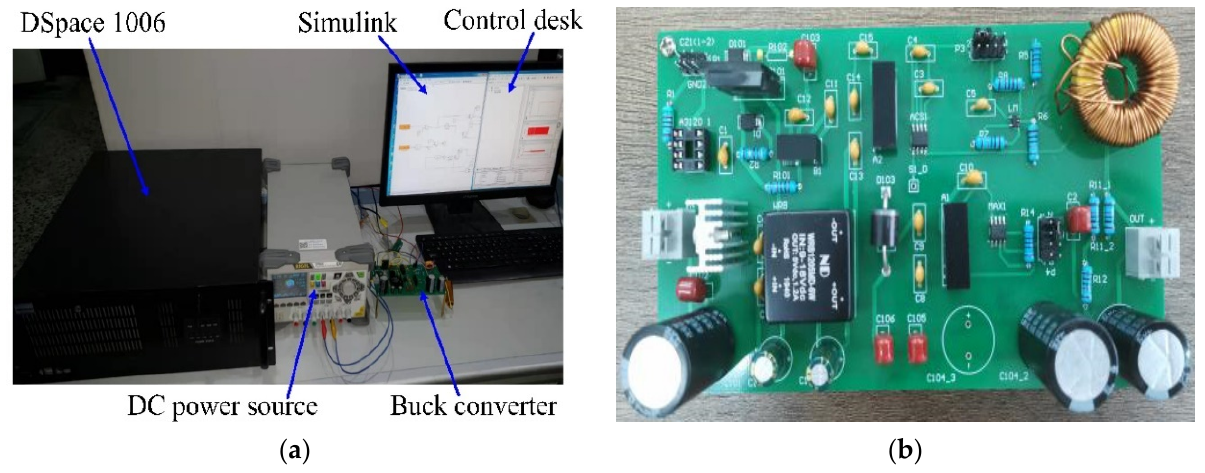
Figure 8. DSpace experiment platform of the buck converter system: ( a ) Buck converter control system; ( b ) Hardware of buck converter.